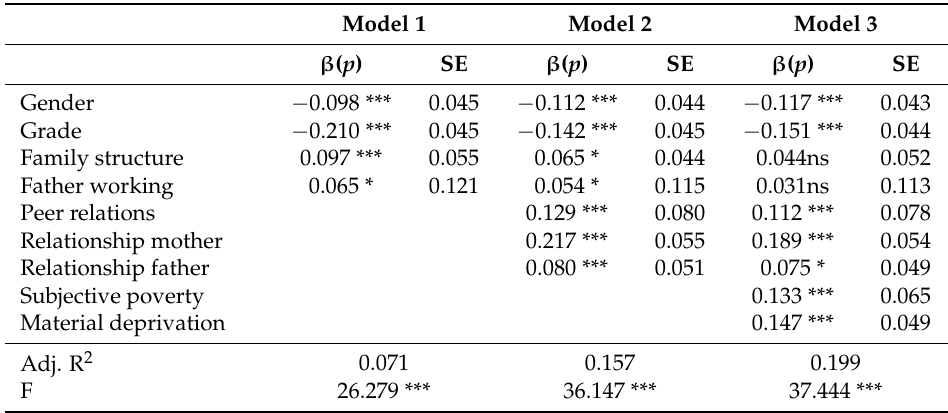
Table 2. Children’s life satisfaction explained by socio-demographic variables, relationship variables and subjective poverty variables